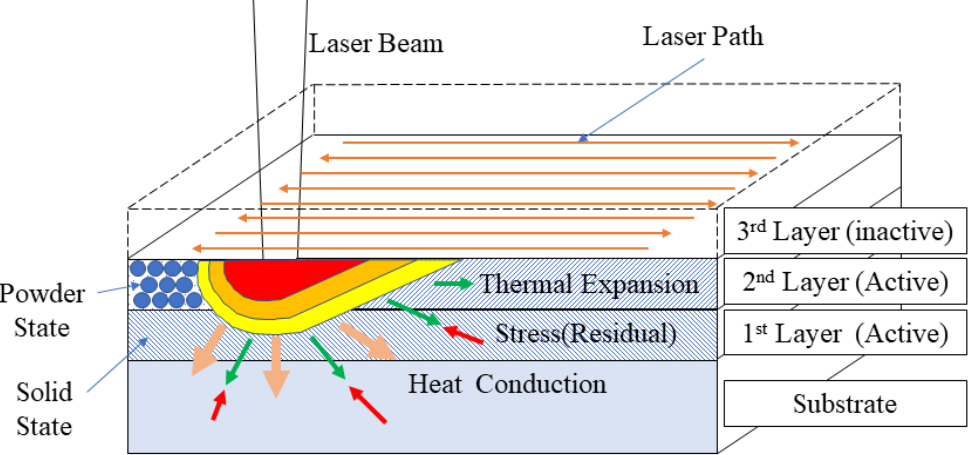
Figure 1. Schematic illustration of SLM simulation [8]: (green arrow) forces due to thermal expan- sion; (red arrow) repulsive force due to thermal expansion; (orange arrow) heat transfer into the material interior.